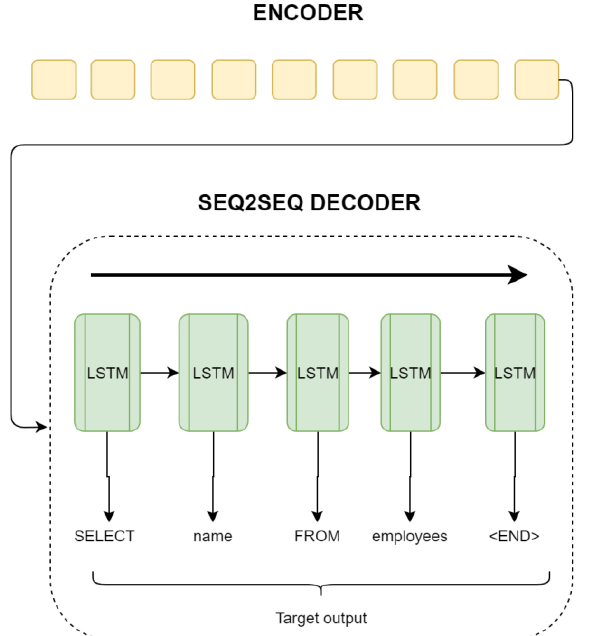
Figure.2. An example of a sequential decoder.